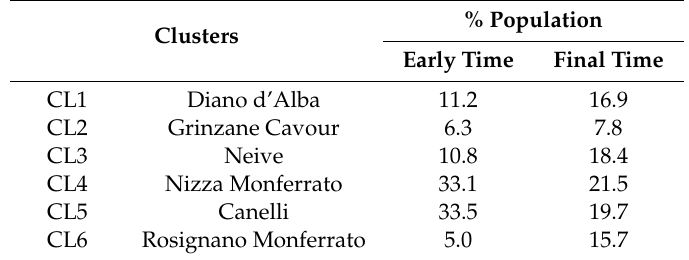
Figure 6. Simulation of the population mobility in the LRM clusters system. Table 9. Percentage distribution of the population dynamics in the LRM landscape as resulting from the integrated model.